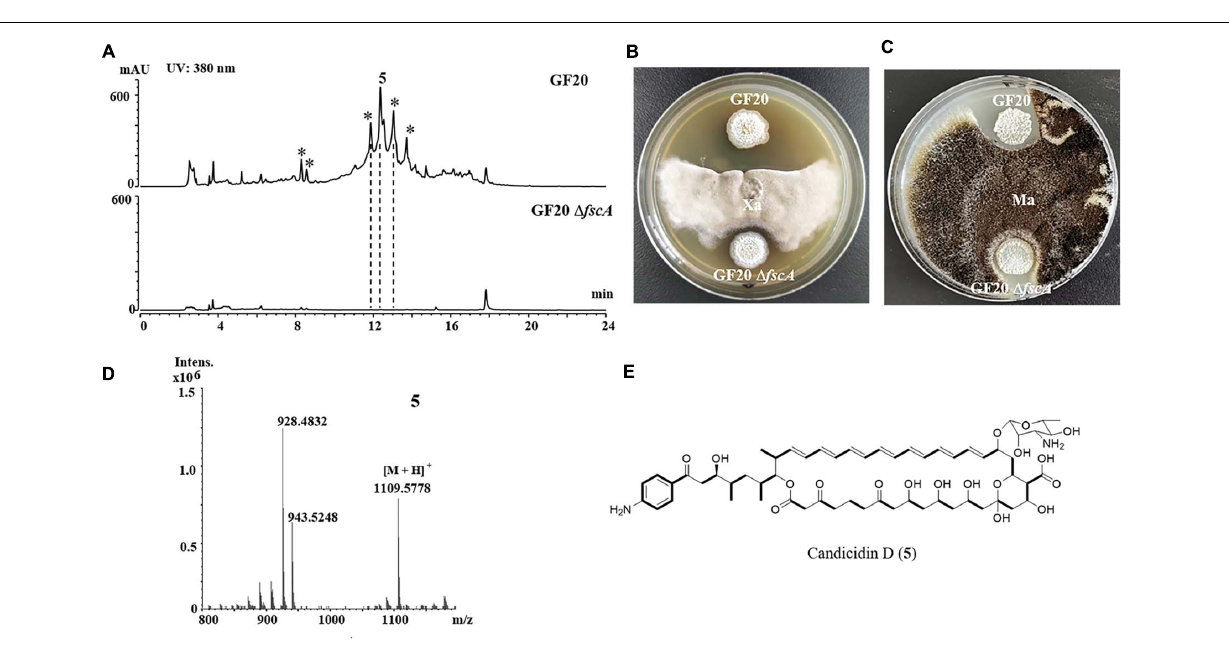
to chemical instability of polyenes (Worthen et al., 2001), finally only two pentene compounds (pentamycin and 1 (cid:48) 14- dihydroxyisochainin) were purified from Streptomyces sp. HF10